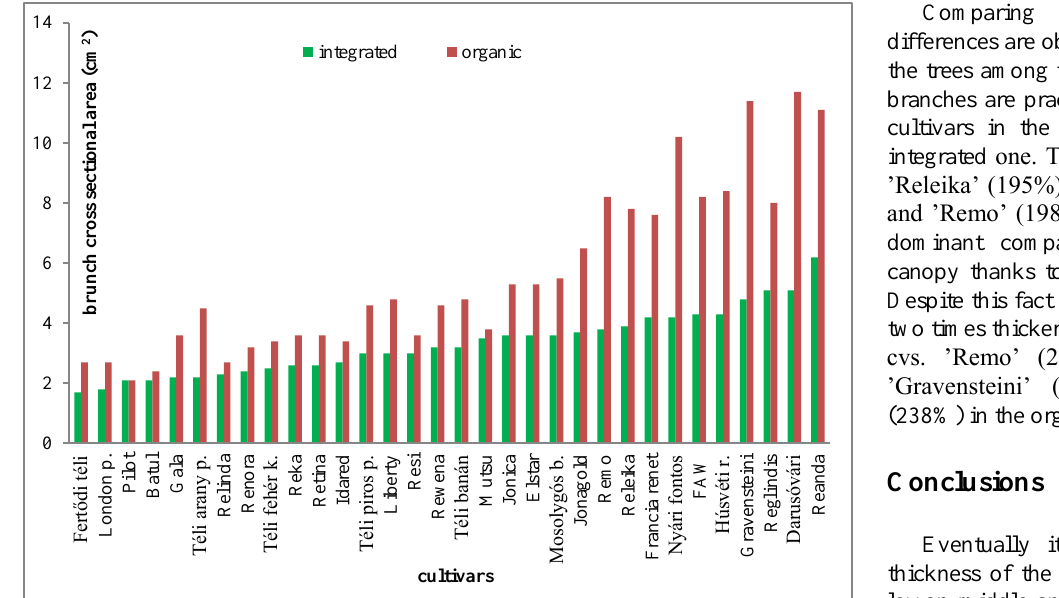
Figure 3. Cross sectional area of branches in the upper region of apple trees aged 14 (Debrecen - Pallag, with the weakest branch. It is also well visible, that all cultivar